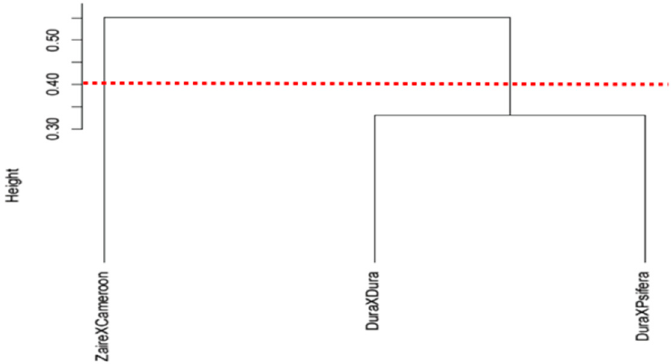
Figure 3. Jaccard-based distance dendrogram of one-year-old oil palm crosses/genotypes plotted by root lignin content shows grouping of DuraXDura and DuraXPsifera under a clade at height = 0.35. Red dotted line indicates height cut-off at 0.40. The oil palm seedlings are characterized as following: ZaireXCameroon; tolerant to BSR, DuraXPsifera; intermediately tolerant to BSR, and DuraXDura; susceptible to BSR.